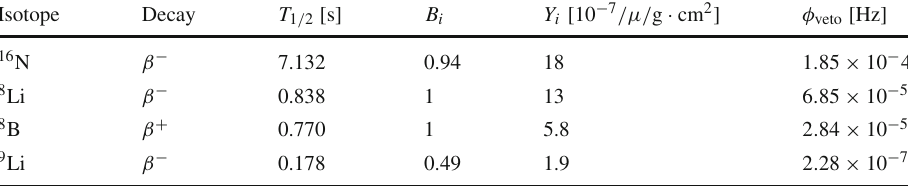
emitting β products of